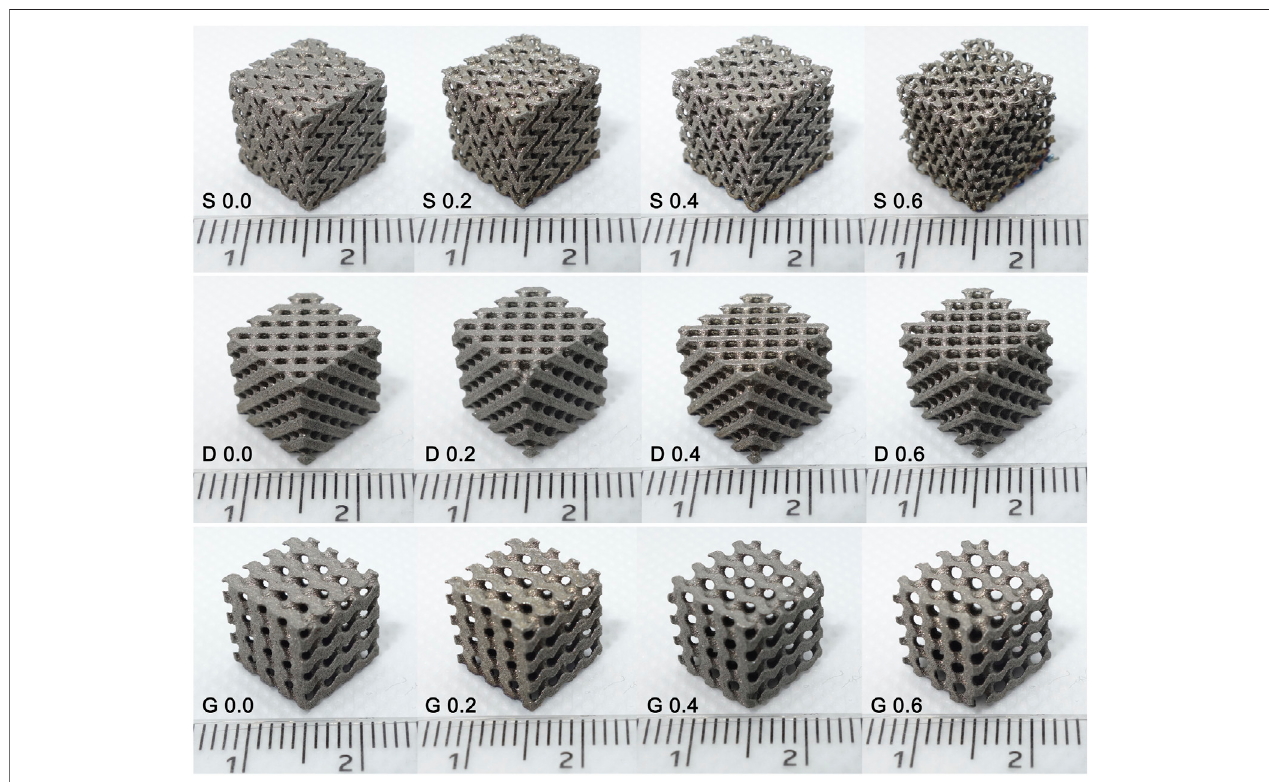
FIGURE2| Samplesmanufactured byselectivelasermelting.Theappearanceofthemanufacturedspecimenswasbasicallyconsistentwiththedesignedmodels that were presented in Figure 3 .